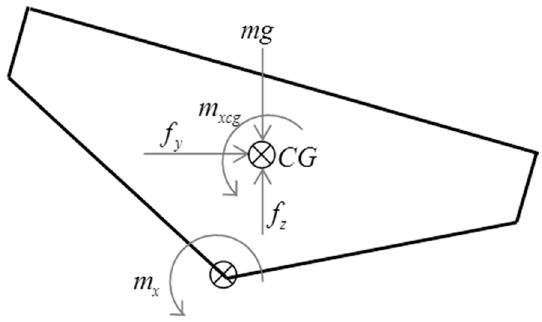
Figure 5. Forces diagram in the wedge.